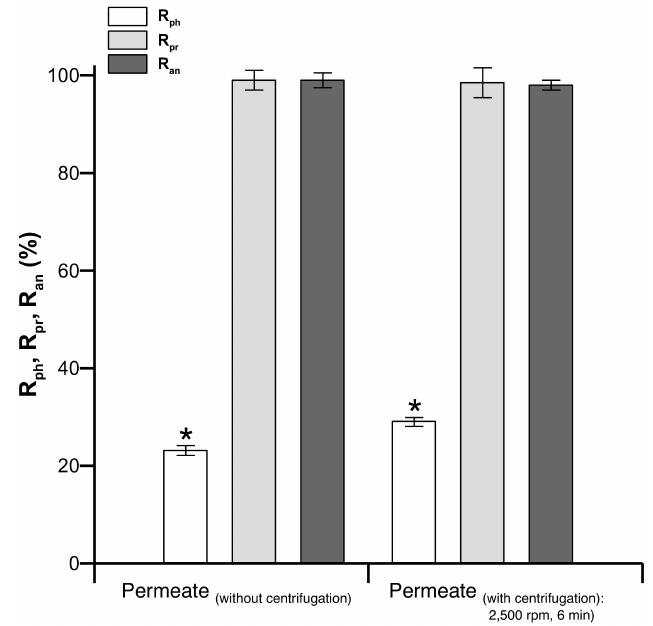
Figure 1. Polyphenol, protein and anthocyanin recovery after the ultrafiltration of purple sweet potato (PSP) extracts, both without centrifugation and with centrifugation at 2500 rpm during 6 min. Error bars correspond to standard deviations. Significant differences were marked with asterisk.